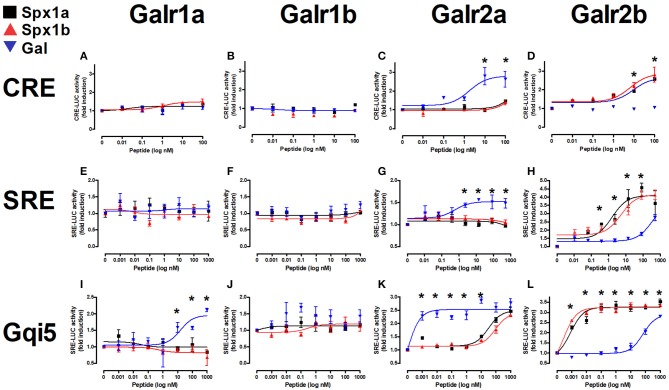
In vitro reporter assays for tilapia Galanin receptors. Tilapia Galrs were cotransfected with either CRE-luc (A–D), SRE-Luc (E–H), or Gqi5 (I–L) into Cos7 cells and treated with either Spx1a (black squares), Spx1b (red triangles), or human galanin (Gal; blue upside-down triangles). Data are represented as mean ± SEM fold-change in luciferase activity over basal (no treatment). Means marked by asterisks differ significantly (p < 0.05).